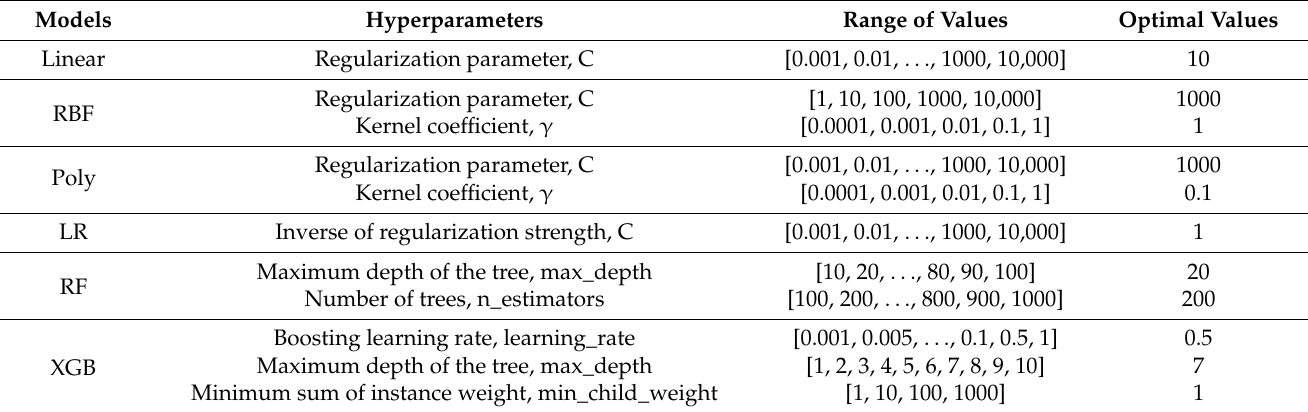
Figure 9. 10-fold CV accuracy for parameter-tuned classification methods (Case 2). Table 6. Hyperparameter tuning for each classification method (Case